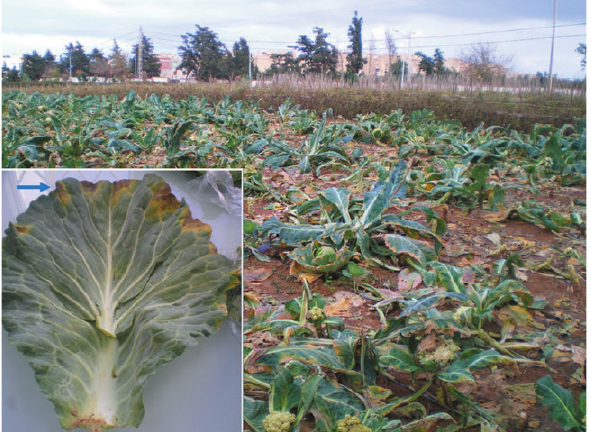
Figure 1. Symptoms of black rot in a cauliflower crop (Zéralda, Wilaya of Algeries, Algeria), with yellow V- shaped lesions at mar- gin of a leaf (blue arrow).